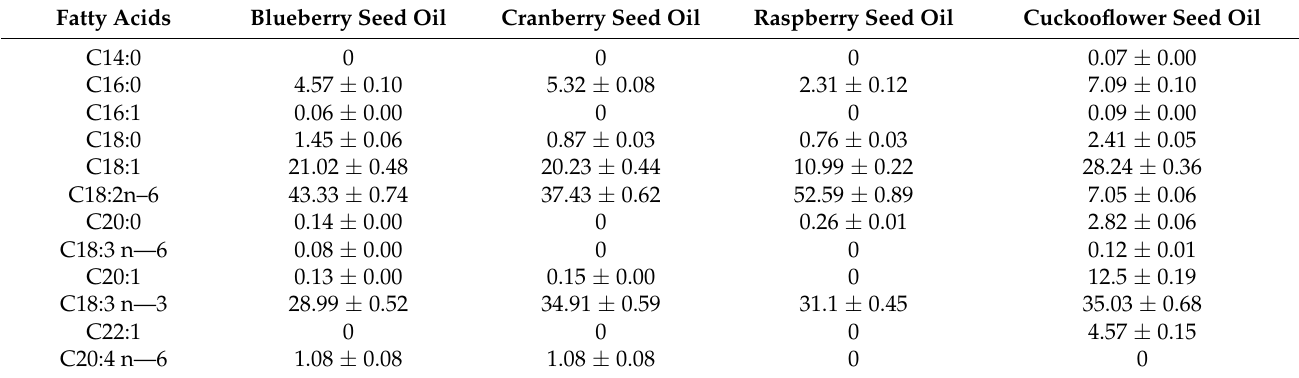
Table 2. Fatty acid composition of blueberry, cranberry, raspberry and cuckooflower seed oils obtained by sonification (%). Fatty